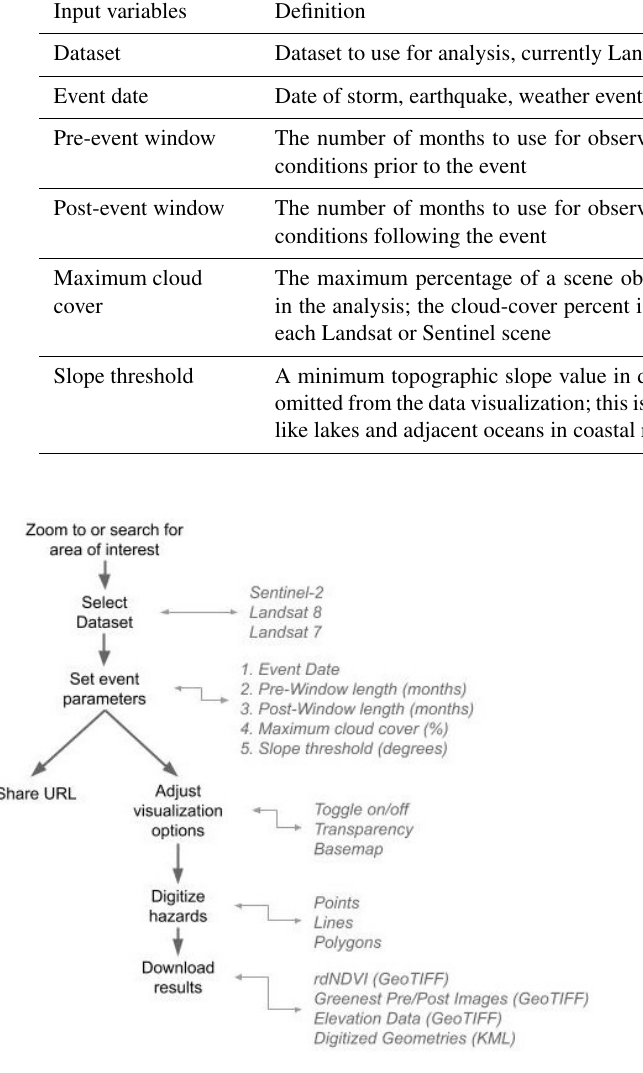
Figure 2. Suggested HazMapper workflows, including a branching point to share the URL or continue with analysis. Workflow cul- minates in downloading geographic tagged image file format (Geo- TIFF) files suitable for input into a GIS for advanced analysis or visualization functions. If the user digitizes key areas of interest or hazards such as mass-wasting processes, burn, or inundation ex- tents, these can be exported as KML files for sharing or viewing in Google Earth.